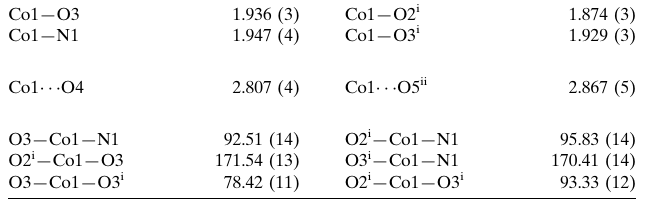
Selected geometric parameters (A˚ , (cid:2) ).